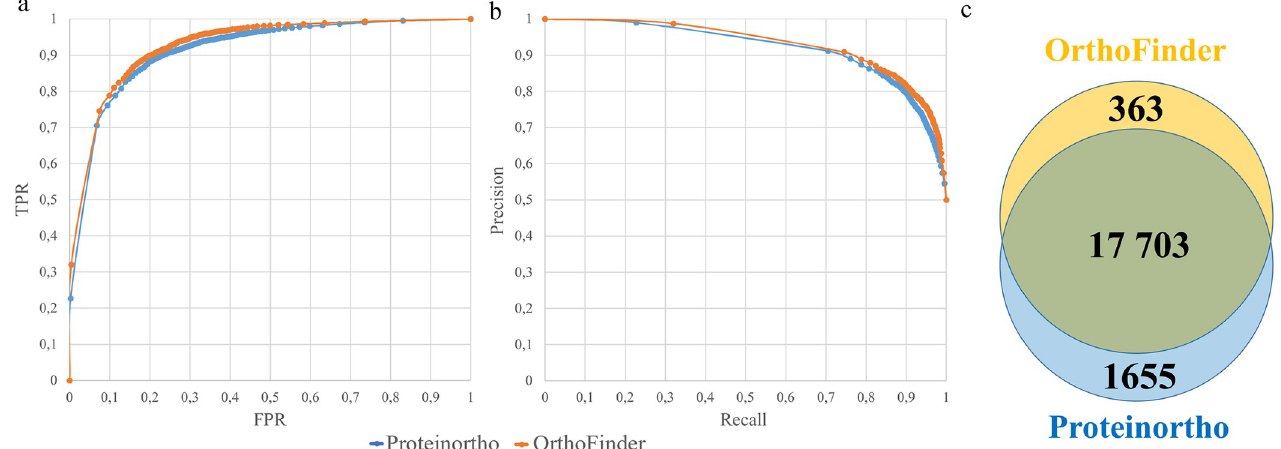
Fig 3. Testing ISEEML efficiency under alternative methods of orthology inference. a: ROC-curve for the classifiers based the results of Proteinortho and Orthofinder. b: Precision-recall curve for the classifiers based the results of Proteinortho and Orthofinder c: Venn diagram showing the overlap between results of the classification based on Proteinortho and Orthofinder (number denote the number of pairs with predicted ES > 0.5).